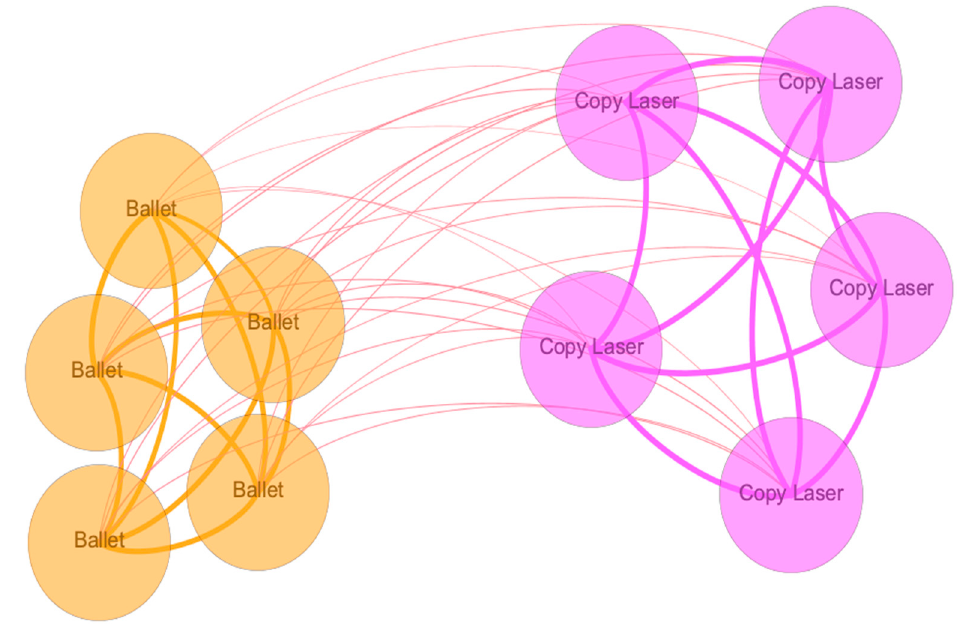
Figure 7. Test 2, another test performed to distinguish between two different paper types; Copy Laser and Ballet using the algorithm proposed in [35].